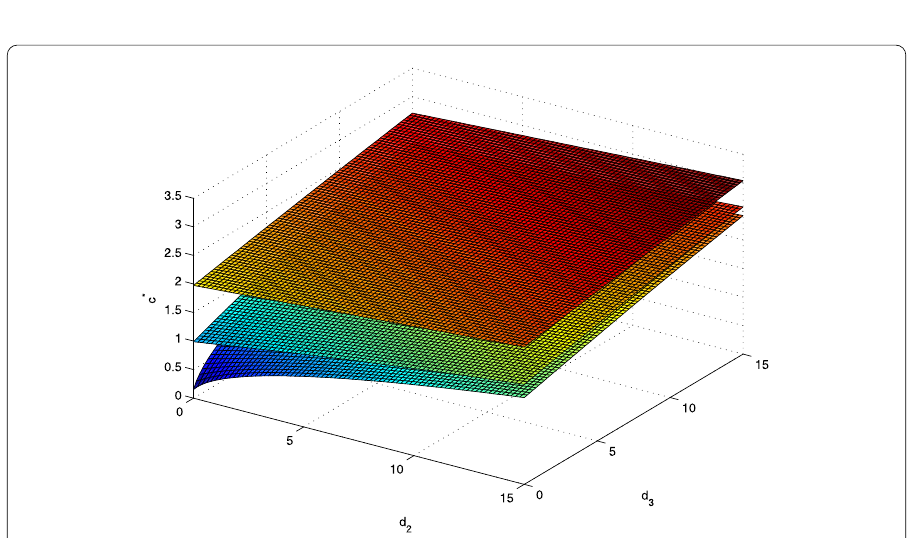
Figure 3 The surface of c ∗ ( d 2 , d 3 ) for the first model. Let α = 1, β = 3, S 0 = 1, γ = 1.5, and τ = 1 be fixed. We can see that the minimal wave speed c ∗ increases with respect to d 2 and d 3 . Moreover, three surfaces from top to bottom are generated by taking ρ = 3,2,0.2,